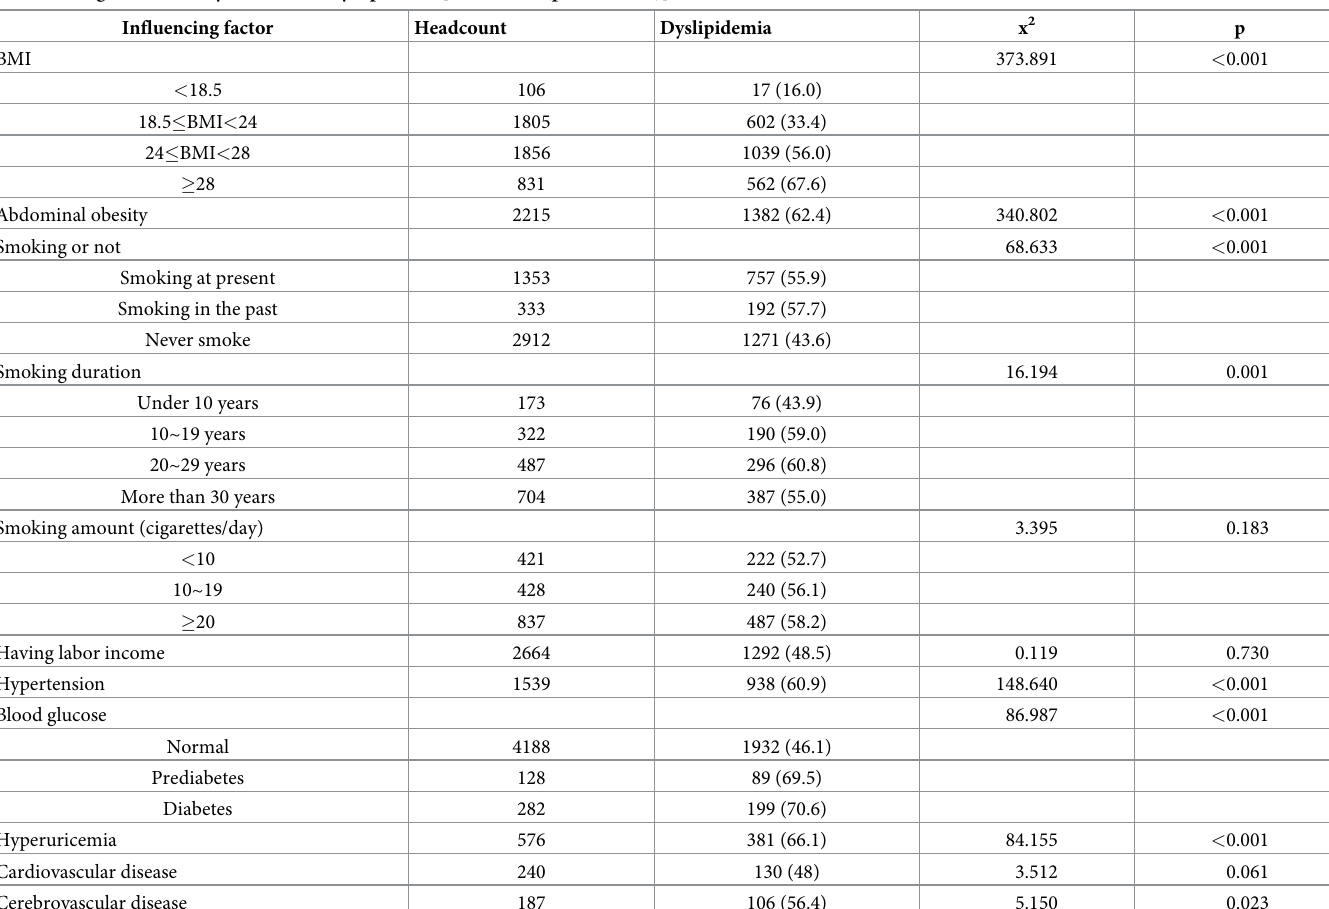
Hyperuricemia: Women, uric acid (UA) � 420 μ mol/and men, UA � 360 μ mol/L; Cardiovascular disease: Participants have been diagnosed with myocardial infarction, angina pectoris, and coronary heart disease; Cerebrovascular disease: Participants have previously diagnosed with cerebral insufficiency, lacunar infarction, thrombosis, hemorrhage, and subarachnoid